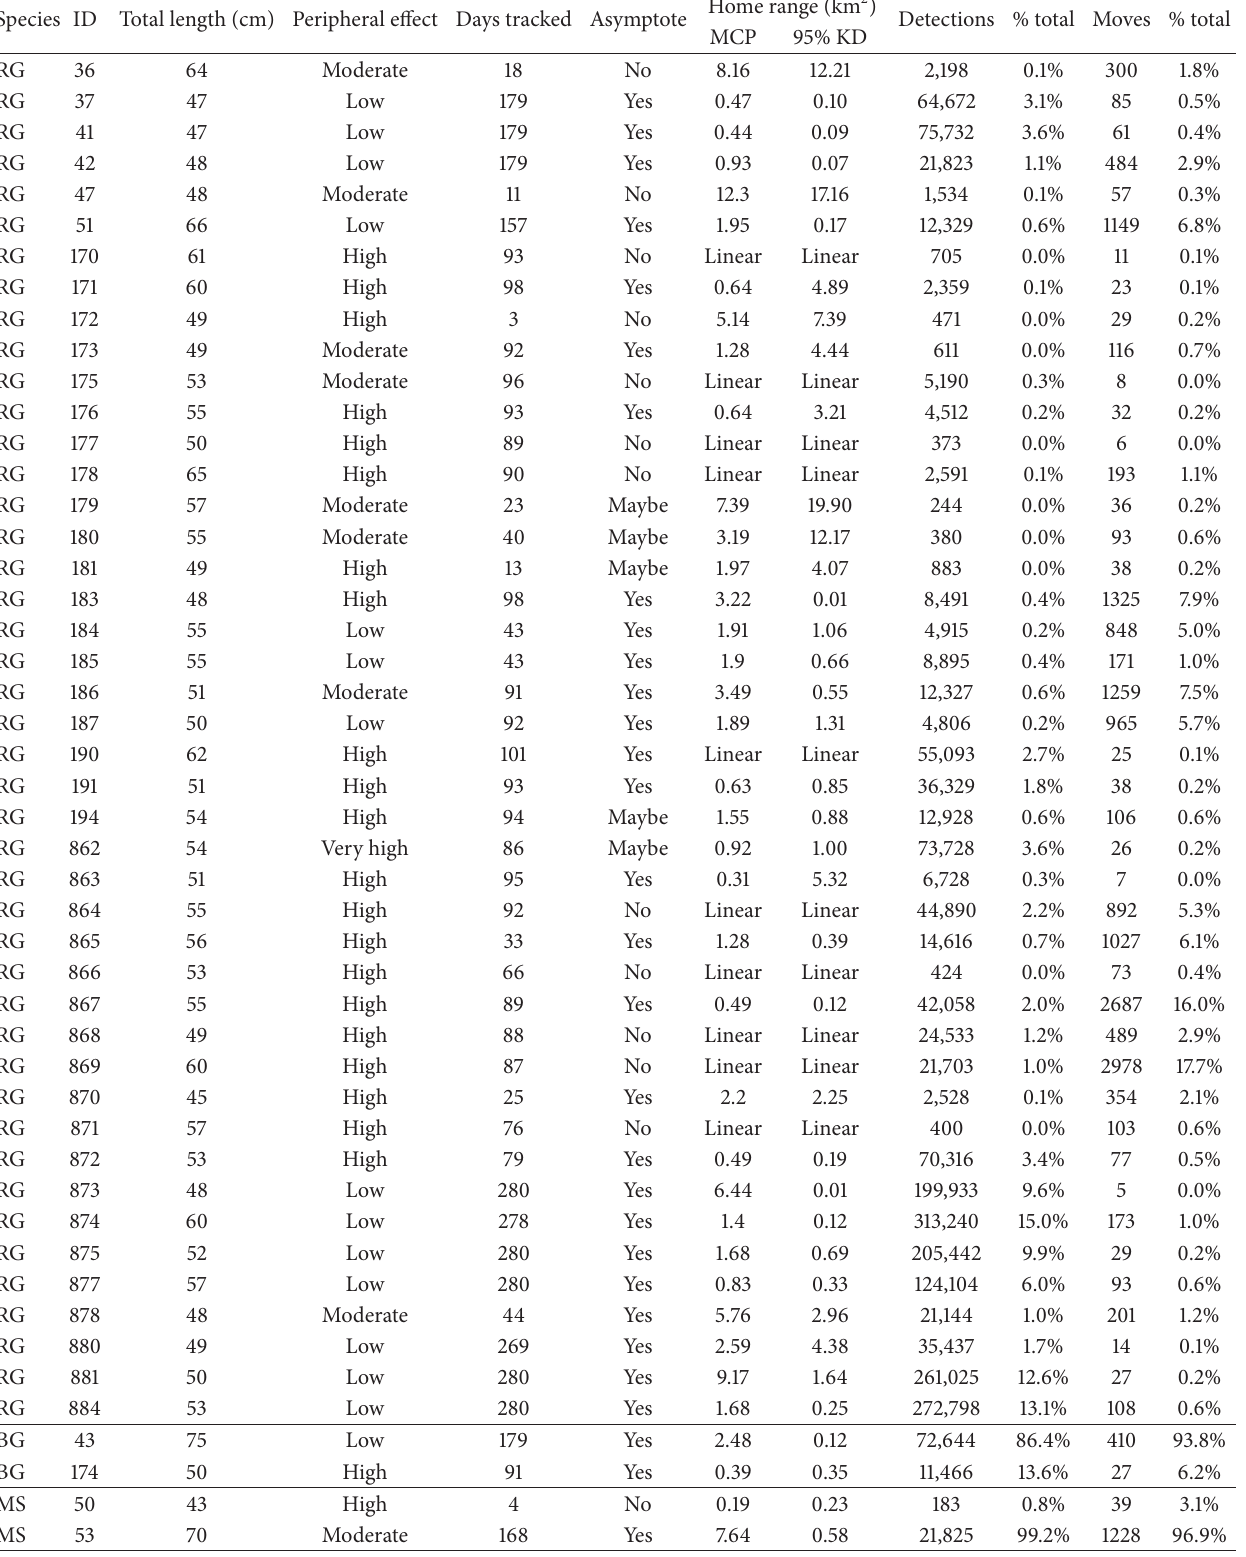
Table 3: Empirical movement and home range (MCP: minimum convex polygon; KDE: kernel density estimate; km 2 ) estimates from acoustically tracked red grouper (RG), black grouper (BG), and mutton snapper (MS) in Dry Tortugas,